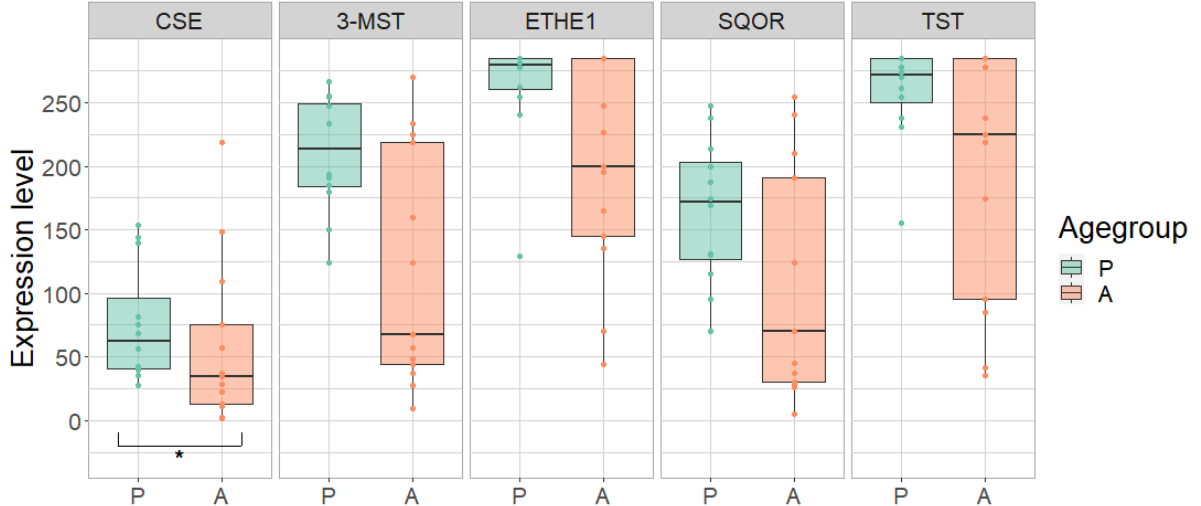
Figure 5. Expression of cystathionine- γ -lyase (CSE), 3-mercapto-sulfurtransferase (3-MST), ethylmalonic encephalopathy 1 protein (ETHE1), sulfide:quinone oxidoreductase (SQOR) and thiosulfate sulfurtransferase (TST) in pediatric (P) and adult (A) samples in the ascending colon of pediatric (P) and adult (A) healthy controls. Range of expression levels from a minimum of 0 to a maximum of 300. * = p -value < 0.05. Table 4. Expression as mean with standard deviation (SD), absolute reduction and percentage as well as p -value of the ascending colon of the healthy control group (C) separated by age group. Pediatric (P); adult (A). cystathionine- γ -lyase (CSE), 3-mercapto-sulfurtransferase (3-MST), ethylmalonic encephalopathy 1 protein (ETHE1), sulfide:quinone oxidoreductase (SQOR) and thio- sulfate sulfurtransferase (TST). * = p -value < 0.05.